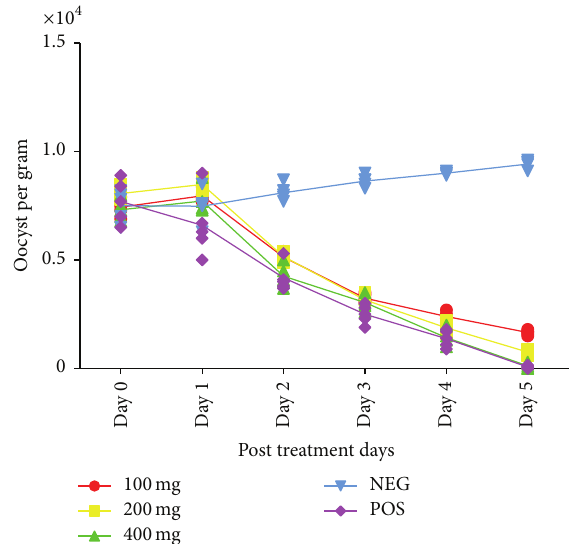
Figure 1: Therapeutic effect of combined extract of Azadirachta indica and Khaya senegalensis on oocyst count of chicken infected with Eimeria oocysts.NEG=negativecontrol(infected,nottreated). POS = positive control (infected and treated with amprolium).